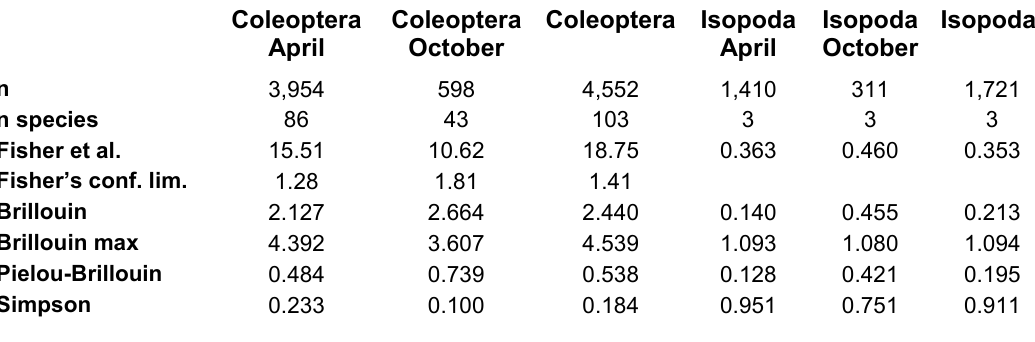
Ecological Indices of the Coleoptera and Isopoda Captured in April and